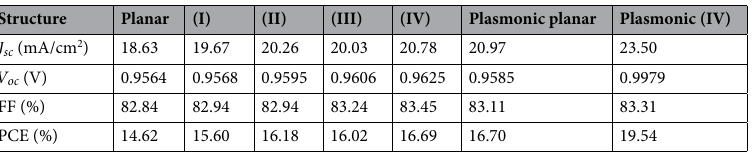
Table 1. The short circuit current density (J sc ), the open circuit voltage (V oc ), the filling factor (FF), and the conversion efficiency of the PSCs with different structures.